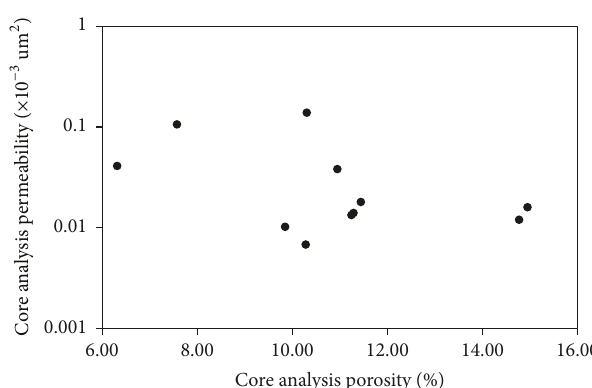
Figure 3: The correlation of porosity and permeability of the samples from Upper Triassic Chang 7 Member, Odors